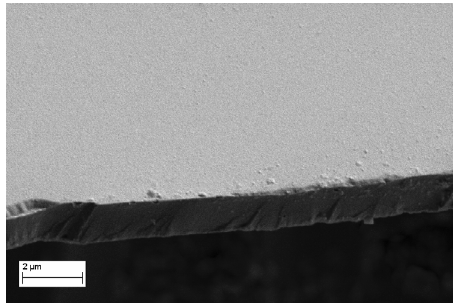
Fig. 2 SEM image of the film annealed at 700 ℃ (sample 2). Film/substrate interface is marked on the